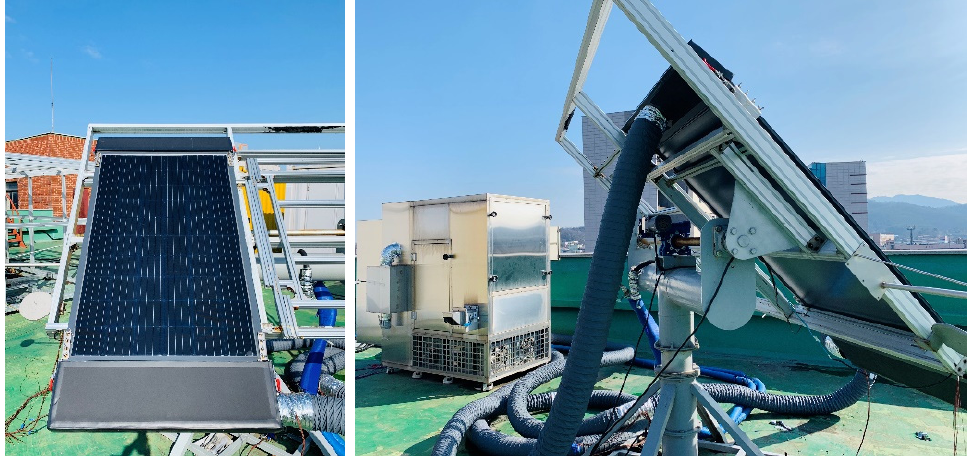
Figure 3. Installation for air-type PVT collector Experiment.